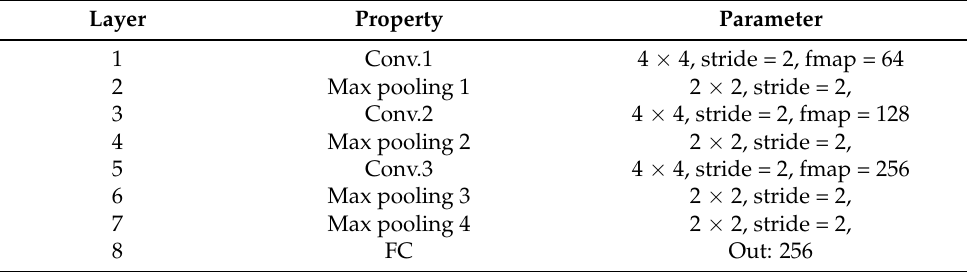
Table 2. The design details of the STrans network